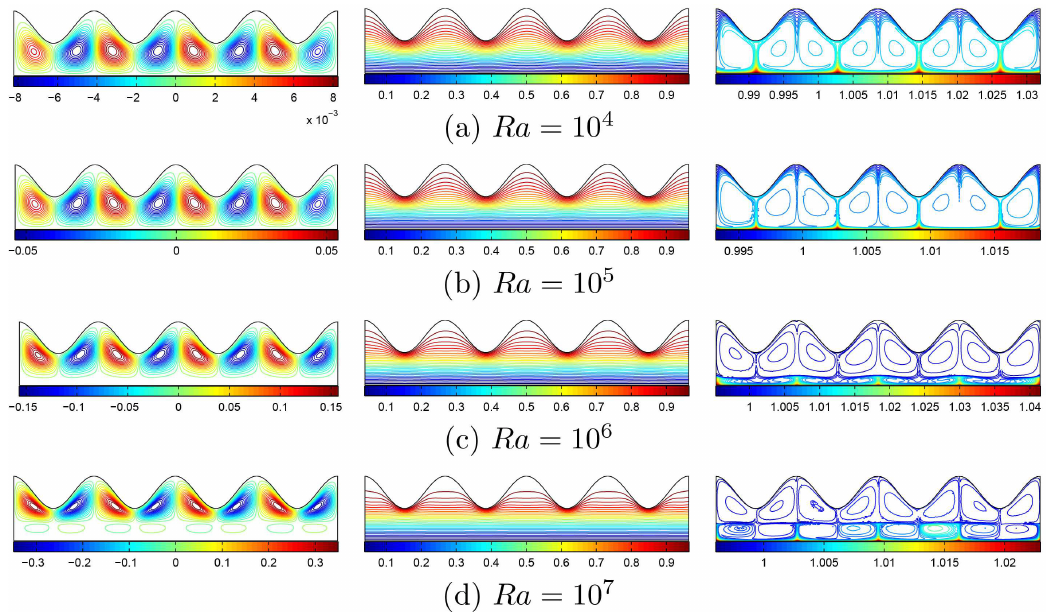
Figure 13. Variation of the streamlines ( left ), isotherms ( middle ), and nanoparticle distribution ( right ) evolution by Rayleigh number ( Ra ) for N = 4, A = 0.1, and φ = 0.02 in the plane ( X , Y